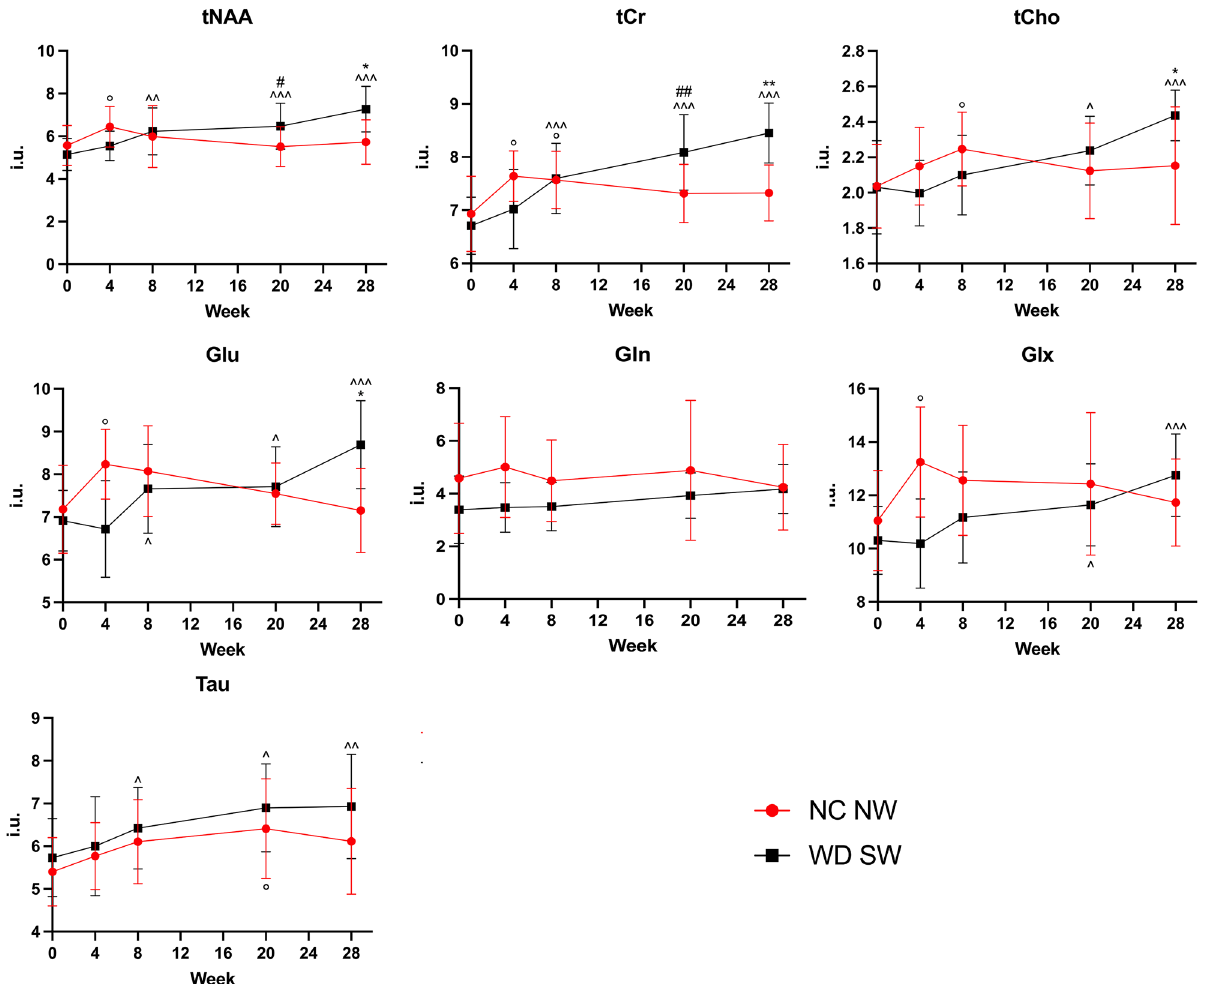
Figure 7. Concentration values of the metabolites for NC NW (red) and WD SW (black) mice during the 28 weeks investigated. The results are expressed as mean ± S.D. *: p < 0.05, **: p < 0.01 vs NC NW T4; #: p < 0.05, ##: p < 0.01 vs NC NW T3; ^: p < 0.05, ^^: p < 0.01, ^^^: p < 0.001 vs WD SW T0; °: p < 0.05 vs NC NW T0. i.u.: institutional units. NC NW: Normal Chow Normal Water, WD SW: Western Diet Sugar Water; T0: 0 weeks, T1: 4 weeks, T2: 8 weeks, T3: 20 weeks, T4: 28 weeks. tNAA, total N-acetylaspartate; tCr, total creatine; tCho, total choline; Glu, glutamate; Gln, Glutamine; Glx, glutamate + glutamine; Tau,